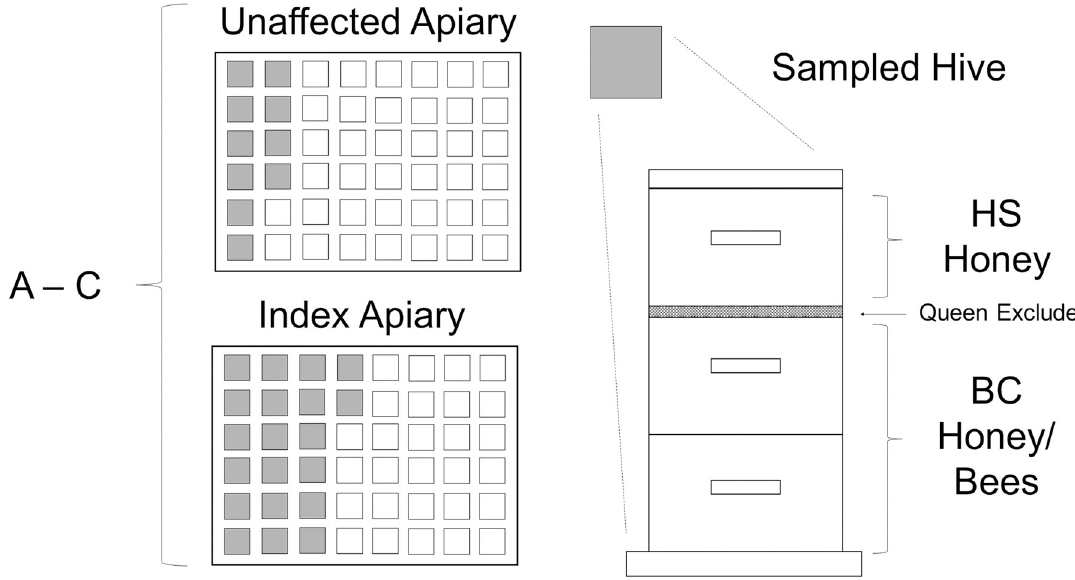
Fig 1. Visual schematic of sampling collection from individual hives. A total of 2 apiaries were sampled for each beekeeping operation (A, B, and C; letters denote operation ID): an apiary with an index case of clinically and laboratory confirmed AFB disease (index apiary) and a second apiary with no detected clinical evidence of AFB disease (unaffected apiary). Twenty randomly selected hives were sampled from the index apiary in each operation (represented by grey-shaded boxes), and ten randomly selected hives were sampled from each unaffected apiary. Samples of honey super honey (HS honey), brood chamber honey (BC honey), and brood chamber bees (BC bees) were collected from each sampled hive, when available.